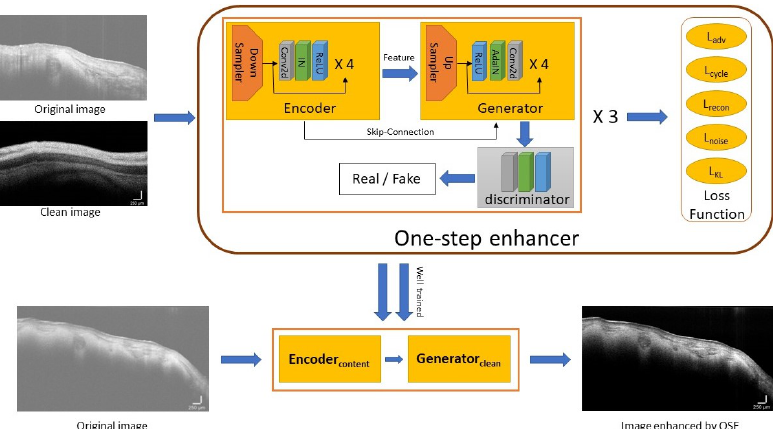
Figure 1. Workflow of proposed OSE image enhancement method: unpaired raw and clean OCT images are used as the input of an unsupervised learning strategy based on disentangled represen- tation and GAN. This process allows the one-step enhancer (OSE) to learn to extract content from low-quality OCT images and generate clean